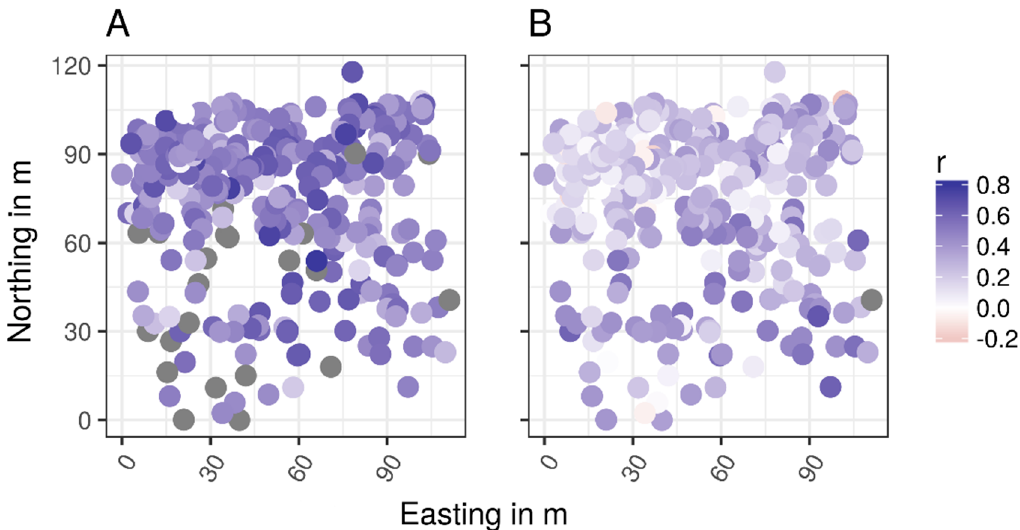
Figure 3. Spatial distribution of the correlation coefficients of individual TRI with April SPEI9. ( A ) shows the correlation for the period 1969–1988 and ( B ) for the period 1989–2008. Grey dots show trees for which no climate correlations could be calculated due to young age and thus insufficient data in the respective time period.